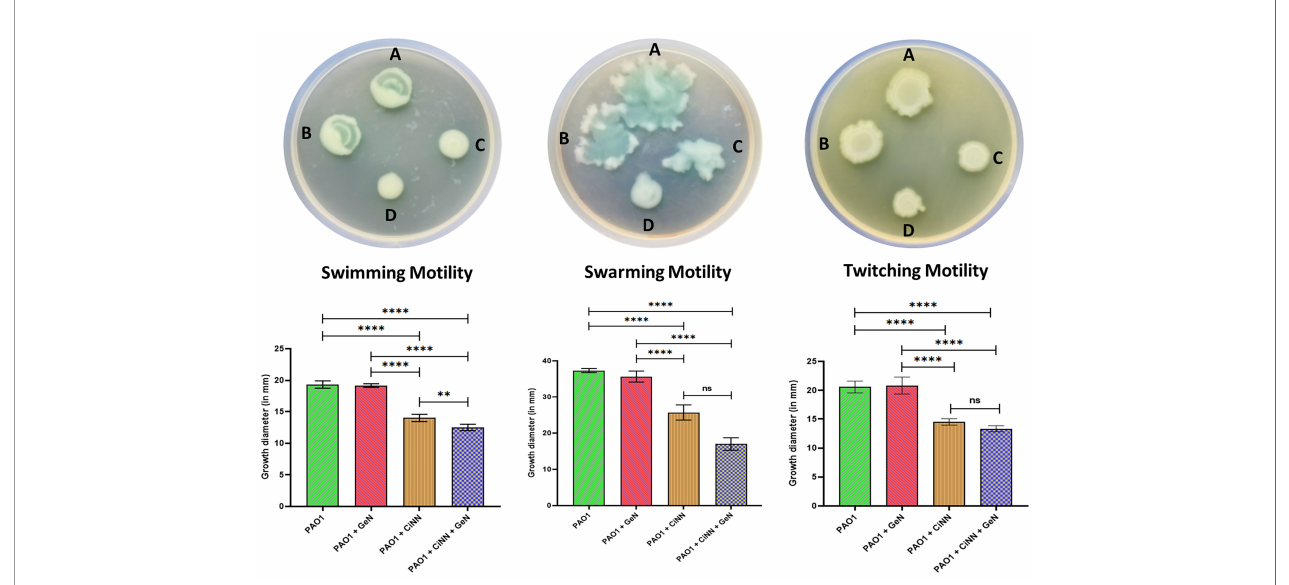
FIGURE 5 | Anti-motility effect of the test drugs on P. aeruginosa PAO1. Upper panel: Bacterial growth on different motility media. (A) Untreated control, (B) GeN- treated culture, (C) CiNN-treated culture, and (D) CiNN-GeN-treated culture. Lower panel: Graphs depicting the diameters of bacterial growth corresponding to each motility media (swimming, swarming, and twitching motility). (ns, not signi fi cant, **p ≤ 0.01, ****p ≤